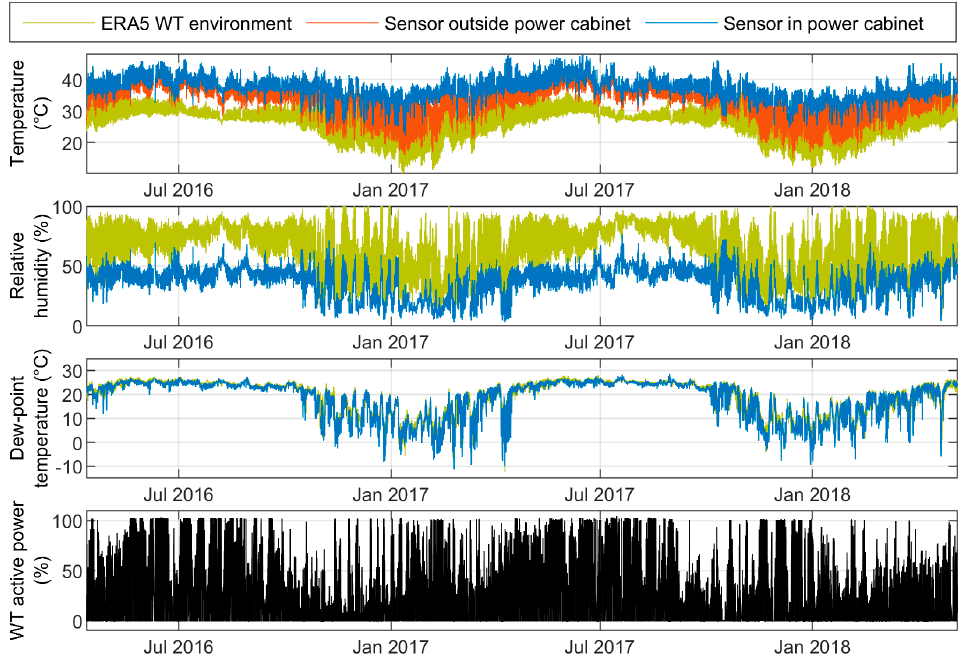
Figure 9. Measured climatic and operating data as well as site-specific ERA5 data from an onshore wind turbine in India with a liquid-cooled converter located in the tower base.